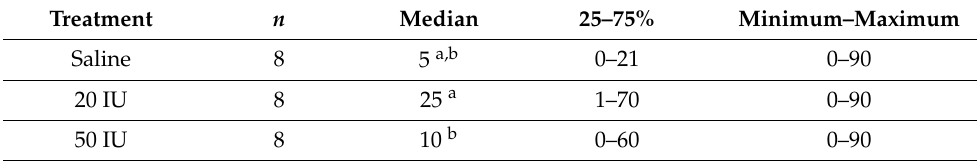
Table 5. Leopard gecko spermatozoa motility (%) by treatment.